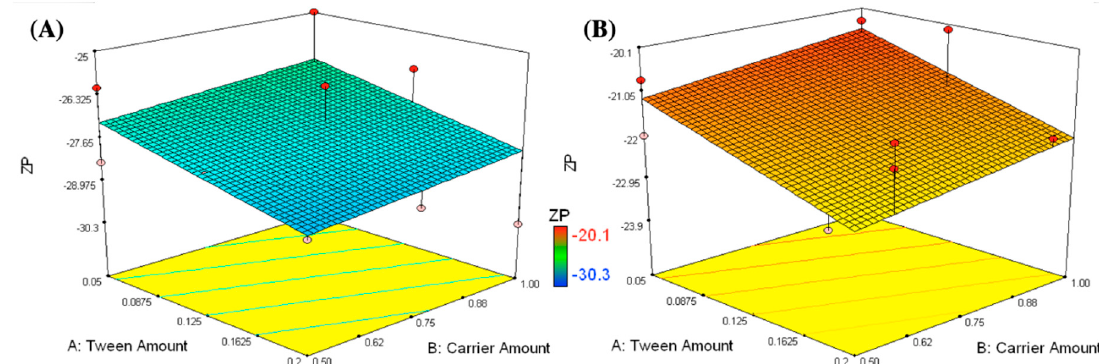
Figure 2. Response surface plots for the effects of T80 (X 1 ) and carrier amounts (X 2 ) on the zeta potential of formulations loaded on different types of carriers (X 3 ); mannitol ( A ) and Aerosil ( B ).